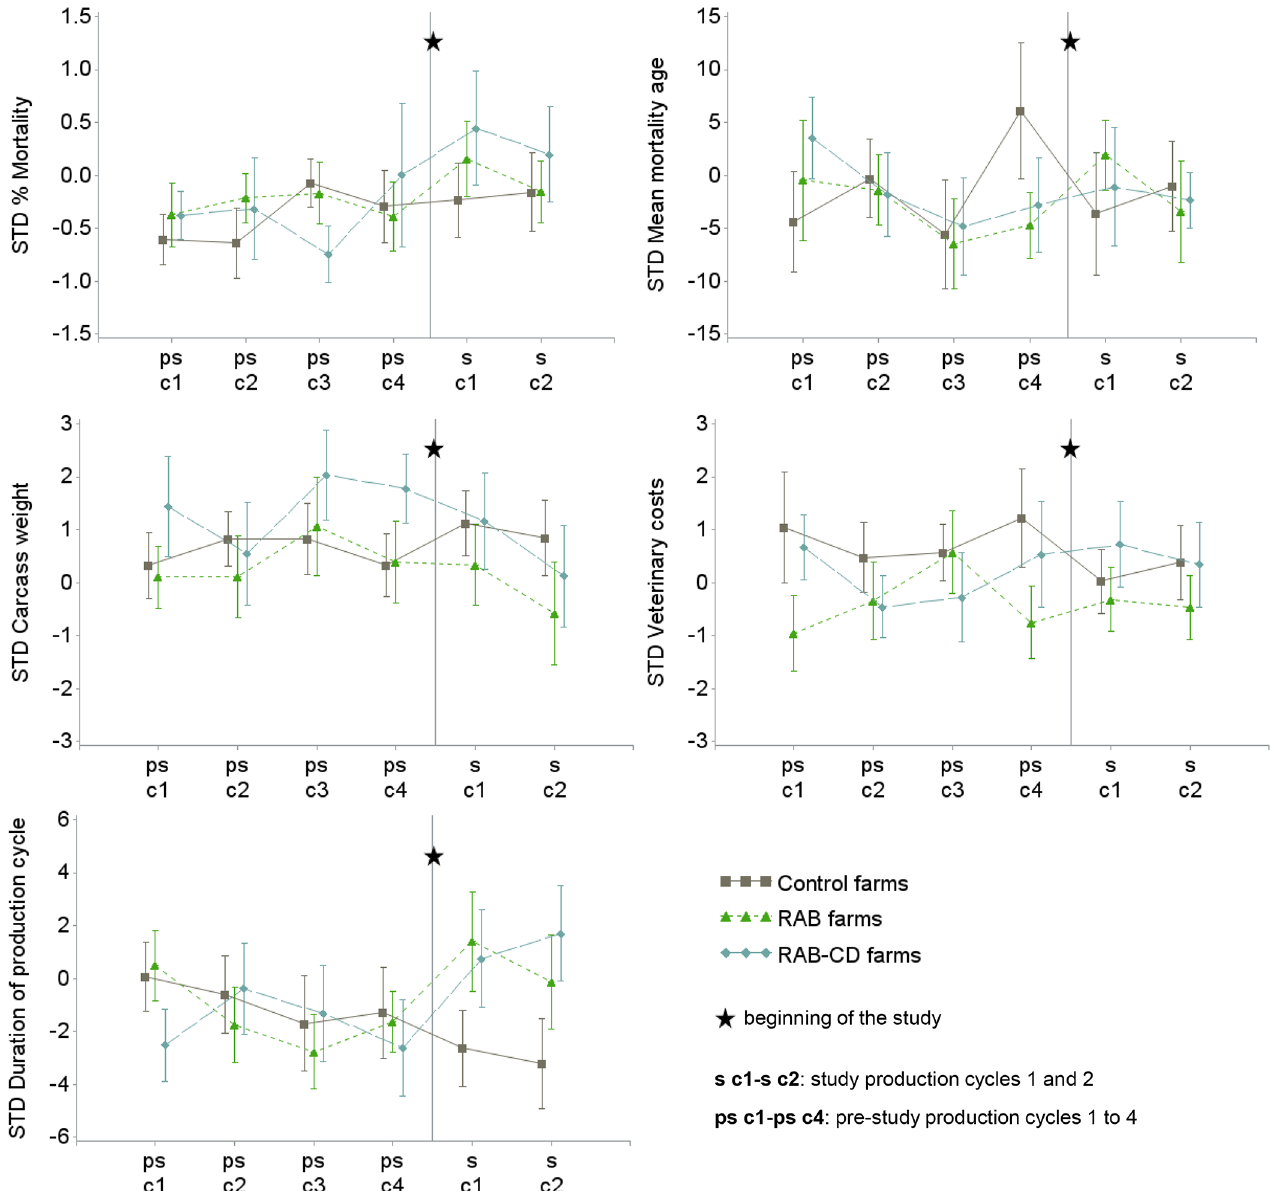
Fig 4. Mean and standard error for each of the standardized (STD) technical parameters in 51 veal calf farms during 4 pre-study production cycles (ps-c1 to ps-c4) and the 2 study cycles (s-c1 and s-c2), the Netherlands 2009 – 2012. For assessing baseline comparability, study arms are also shown during the pre-study period before randomization to any intervention. RAB , farms reducing antimicrobials by protocol; RAB-CD , farms reducing antimicrobials by protocol and applying a cleaning and disinfection program; Control , farms without